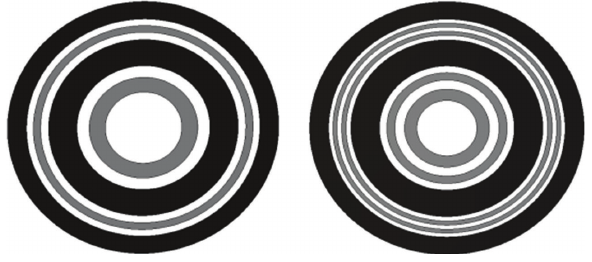
Figure 2: Harmonic-action FZP lens at (a) 3rd harmonic frequency f 3 and (b) 5th harmonic frequency